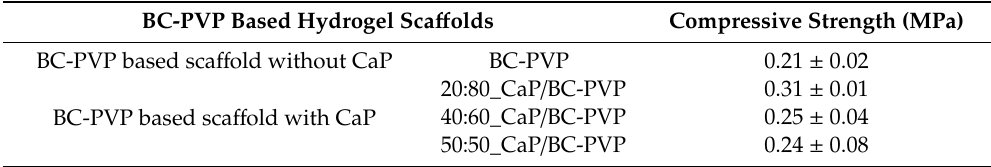
Table 2. The compressive strength of BC based hydrogel scaffolds.